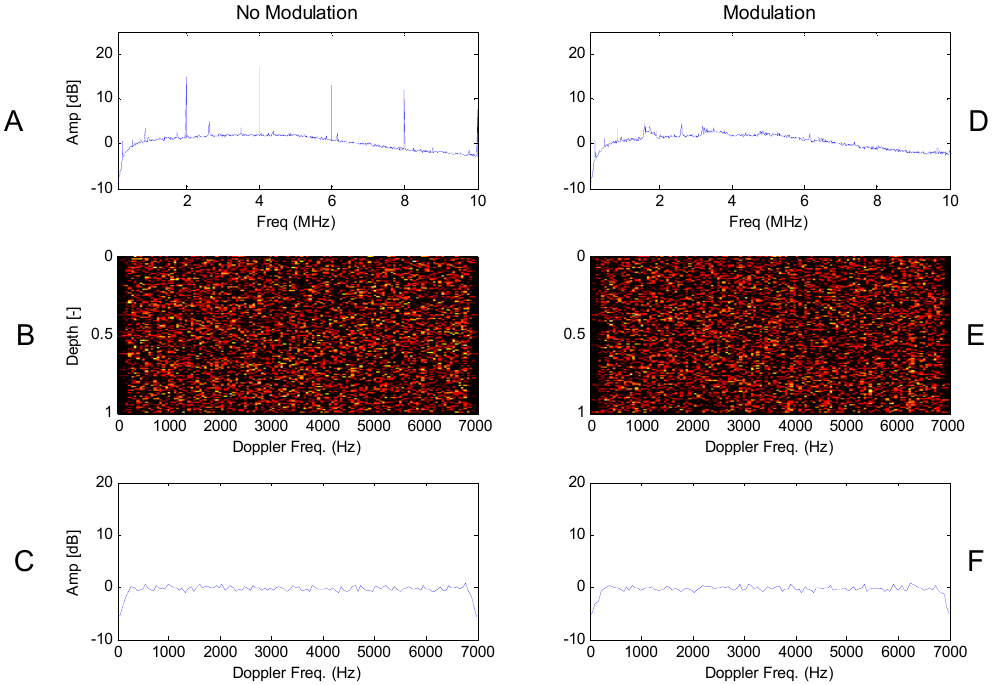
Figure 8. Measurements of the noise produced by a switching regulator working at 1.8 MHz in a Doppler system with T Pri = 143 µ s. ( A , D ) Spectrum of the noise as input into the Doppler system; ( B , E ) Doppler spectral matrix; ( C , F ) spectral density averaged over depths ( k -index).